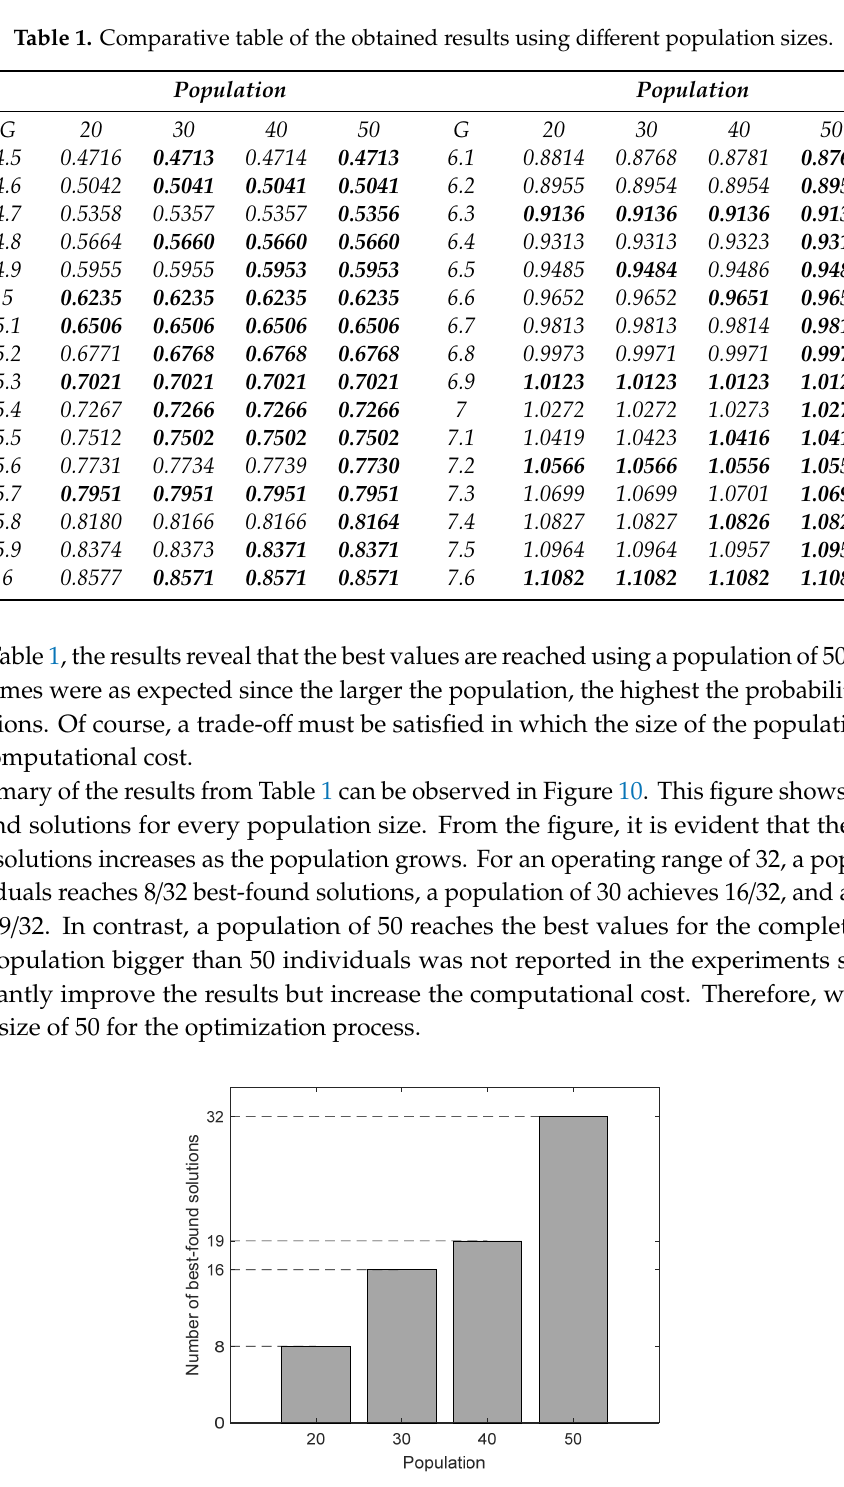
Table 2. Comparative table of the obtained results using different M CR and M F values. G M CR = 0.5 M F = 0.5